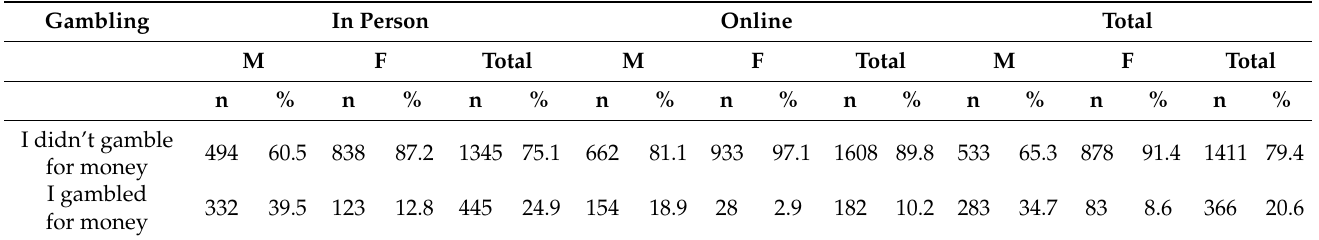
Table 1. Gambling prevalence in the past 12 months by gender and modality (N = 1790).